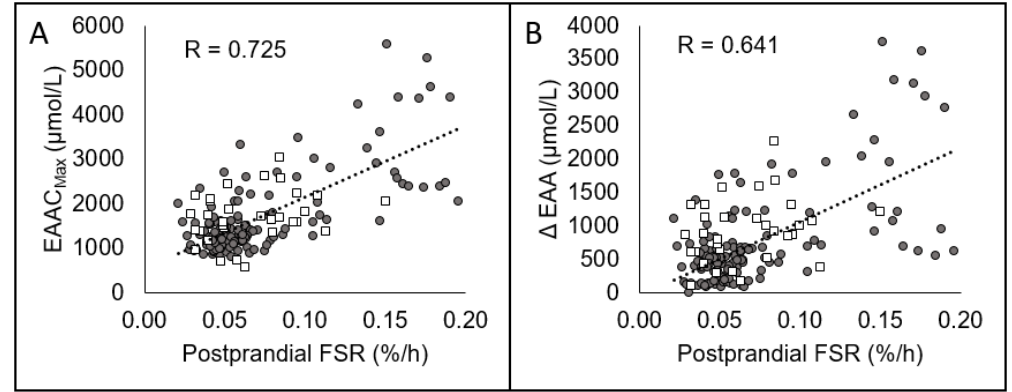
Figure 1. Relationships between postprandial fractional synthetic rate (FSR) to maximum essential amino acid (EAA) concentration (EAAC max ; Panel A ) and the change in EAA concentrations from baseline to EAAC max ( ∆ EAA; Panel B ). Individual participant data from our lab in filled circles ( • ), means gathered from post-feeding data from other studies from the literature [6,26,28–38] in open boxes ( □ ). Means were not used in statistical analysis, they are used to represent consistency in data relationships between labs.